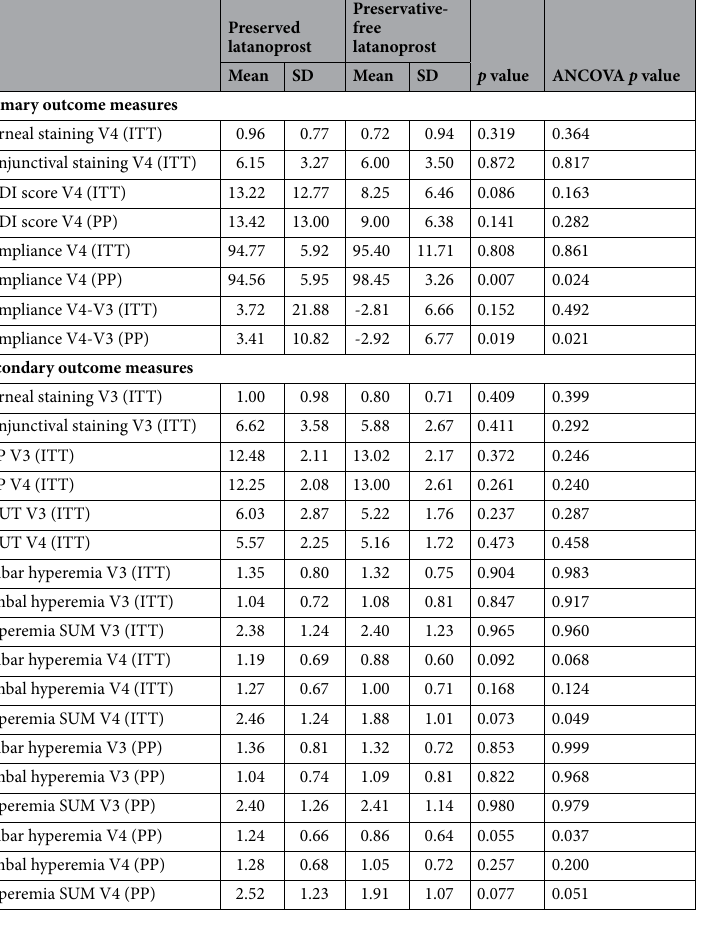
Table 2. Comparison of primary and secondary outcome measures between preserved and preservative- free latanoprost groups. Note that each ANCOVA test was performed within each analysis set (Preserved vs. Preservative-free; ITT set, 26 vs 25; PP set 25 vs 22). *V3, at visit 3; V4, at visit 4; conjunctival staining, sum of all six areas; OSDI, Ocular Surface Disease Index; IOP, intraocular pressure; TBUT, tear break-up time; hyperemia SUM, bulbar + limbal hyperemia score; ITT, intention-to-treat; PP, per